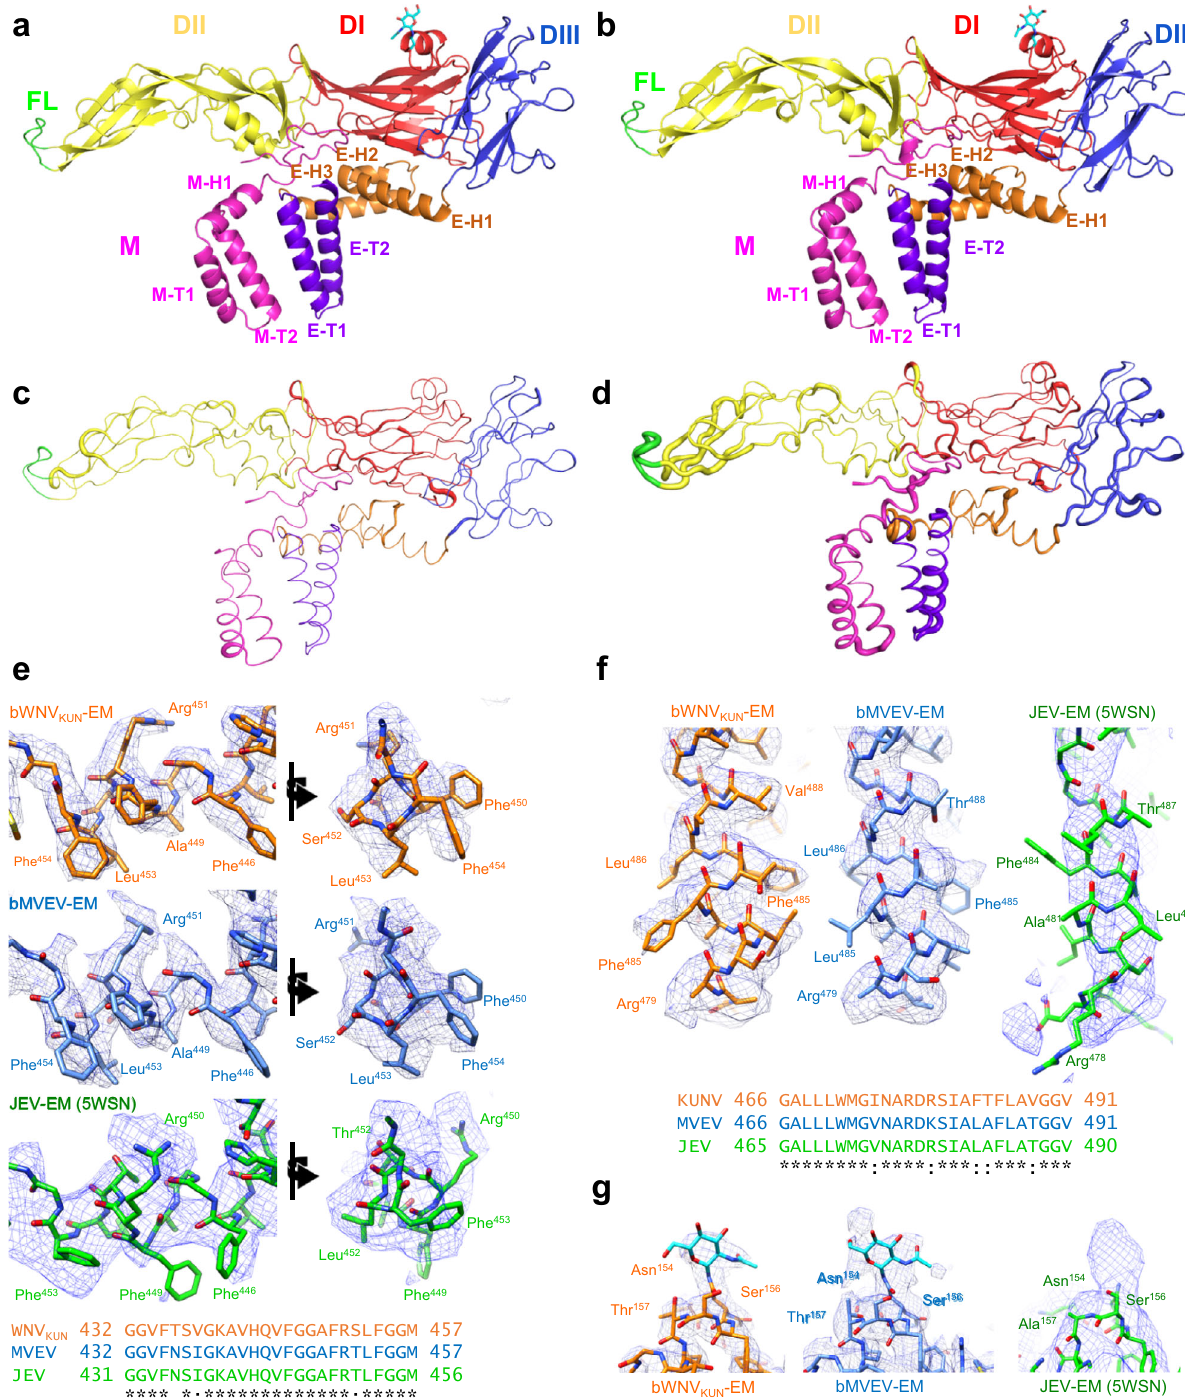
Fig. 4 A high-resolution view of the stem and membrane regions of neurotropic fl aviviruses. a , b A cartoon representation of the a bWNV KUN and b bMVEV structure coloured by domain: E ectodomain 1 (DI, red); E ectodomain 2 (DII, yellow) containing a fusion loop (FL, green) and an N-linked glycan at Asn67 (cyan); E ectodomain 3 (DIII, blue); E membrane domain (purple) consisting of an ‘ anchor ’ of three perimembrane helices (E-H1, E-H2 and E-H3) and a ‘ stem ’ of two transmembrane helices (E-T1 and Ea-T2); M membrane domain (magenta) consisting of a perimembrane helix (M-H1) and two transmembrane helices (M-T1 and M-T2). c , d A ribbon representation of local RMSD differences between the structures of c bMVEV and bWNV KUN and d bMVEV and JEV (PDB: 5WSN) where the ribbon diameter is proportional to the RMSD. For bMVEV/bWNV KUN , the RMSD ranges between 0.05 and 2.93 Å with an average of 0.64 Å, whereas bMVEV/JEV has a range of 0.09 – 4.81 Å and an average of 1.28 Å. e , f A comparison of the density (mesh) for e M-H3 and f E-T2 with the structure of bWNV KUN (orange sticks), bMVEV (blue sticks), and a cryo-EM structure of JEV (green sticks, PDB: 5WSN, EMD- 6685). A sequence alignment is displayed below and coloured accordingly. g The density and model of the glycosylation site at Asn 154 for bWNV KUN (orange sticks), bMVEV (blue sticks) and JEV (green